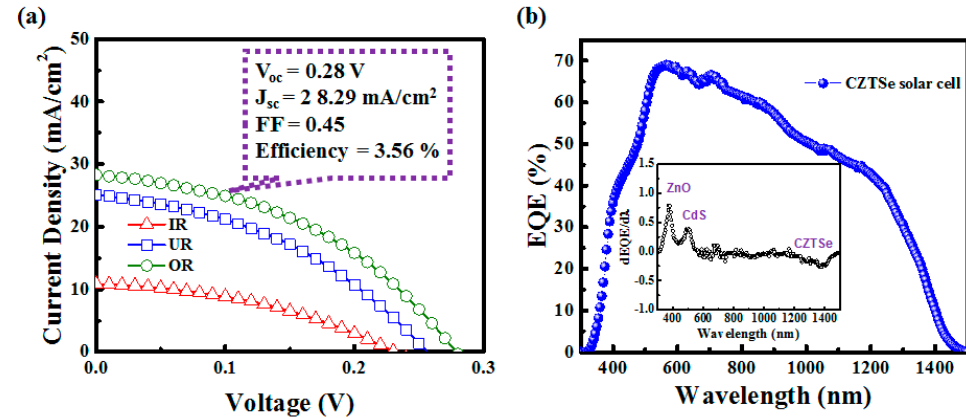
Figure 4. ( a ) J–V measurements for CZTSe solar cells prepared using IR, UR, and OR parameters; ( b ) EQE measurement for the CZTSe solar cell prepared using the OR parameter.